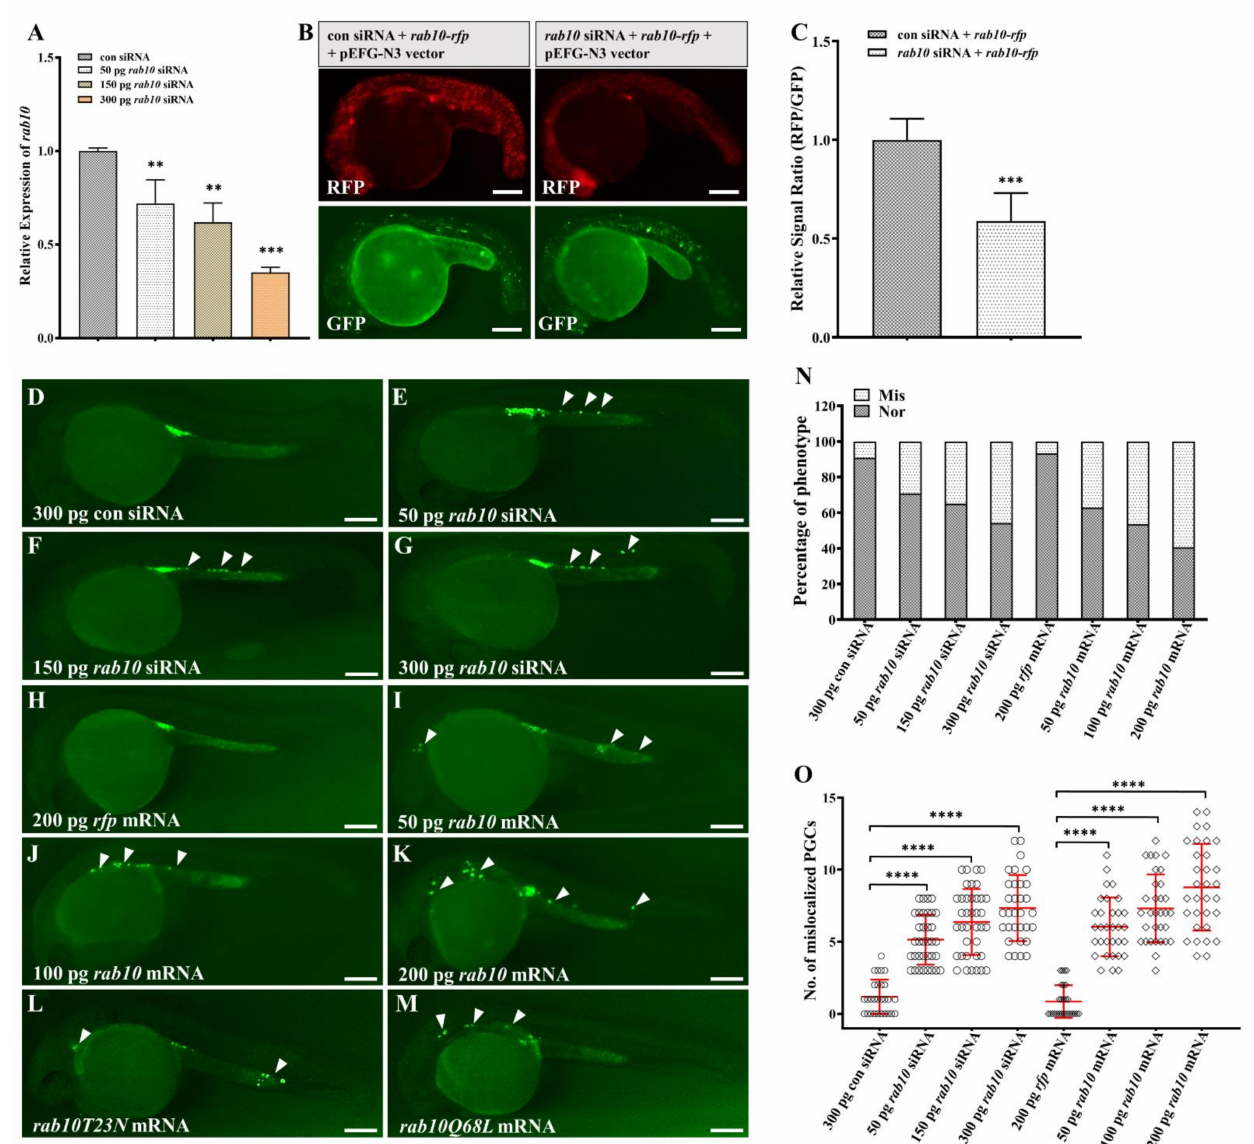
Figure 4. Disruption of rab10 balance leads to PGC mislocalization. ( A ) qRT-PCR analysis of rab10 mRNA in 24hpf embryos injected with control siRNA (con siRNA) or gradient rab10 siRNA (50, 150, 300 pg). ( B ) Co-injection of rab10 siRNA decreased expression of RFP in embryos injected with rab10 - rfp mRNA compared to embryos co − injected with control siRNA. All embryos were co-injected with pEGFP-N3 vector as a control. ( C ) Quantitative representation of the normalized signal intensity in the experiment presented in ( B ). ( D – M ) Representative images of embryos injected with 300 pg con siRNA ( D ), 50 pg rab10 siRNA ( E ), 150 pg rab10 siRNA ( F ), 300 pg rab10 siRNA ( G ), 200 pg rfp mRNA ( H ), 50 pg rab10 mRNA ( I ), 100 pg rab10 mRNA ( J ), 200 pg rab10 mRNA ( K ), rab10T23N mRNA ( L ), and rab10Q68L mRNA ( M ). Arrowheads indicate mislocalized PGCs. ( N ) The percentage of PGC phenotypes in embryos with ( D – K ). ( O ) The number of mislocalized PGCs in each embryo with the experiment presented in ( D – K ). The average number of mislocalized PGCs were showed in red line by mean ± sd. ( A , C , N , O ) The results were representative of more than three independent experiments in triplicate. β -actin was used as an internal control to normalize gene expression levels with 2 − ∆∆ Ct method. ** p < 0.01; *** p < 0.001, **** p < 0.0001. Scale bar, 100 µ